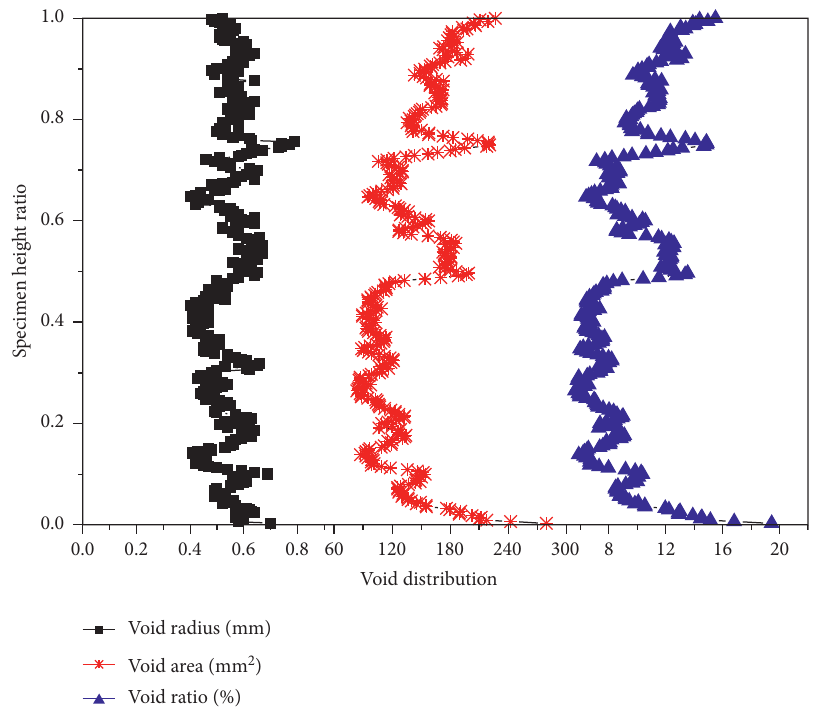
Figure 9: Air size distributions along with the PA13 specimen height ratio.